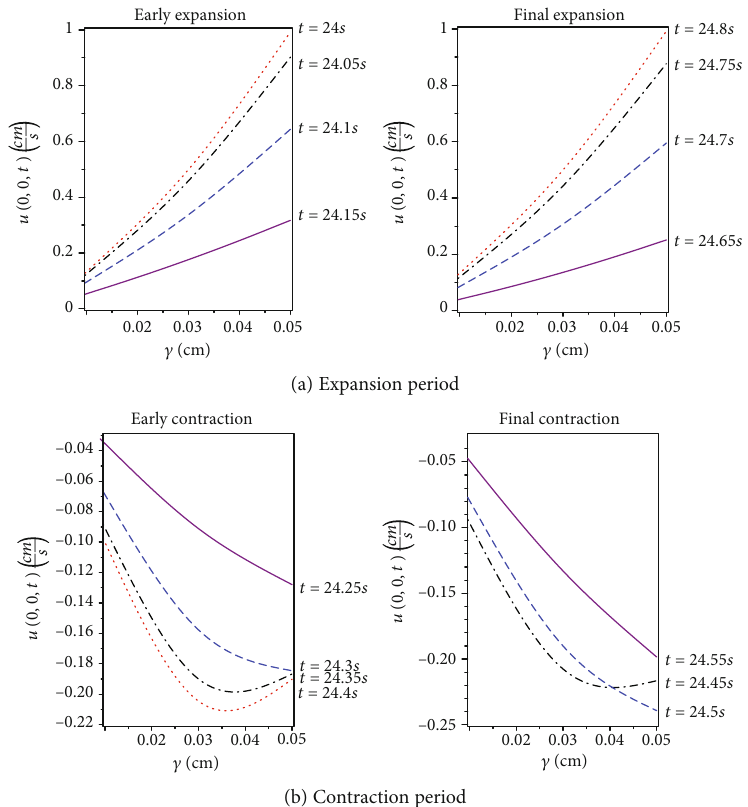
Figure 4: The e ff ect of γ on the velocity u ð 0, 0, t Þ obtained from the model with a slip length of 0.05 at the 30 th wave cycle during two wall conditions: (a) wall expansion; (b) wall